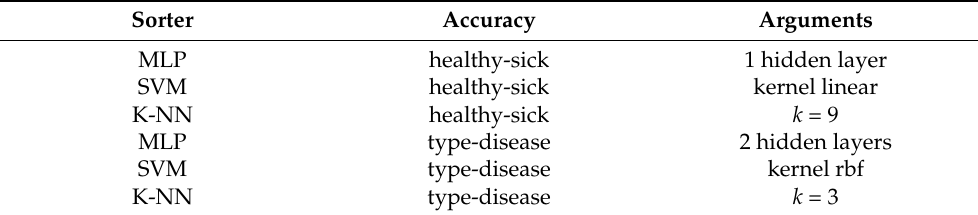
Table 1. Arguments of the classifiers that make up the proposed